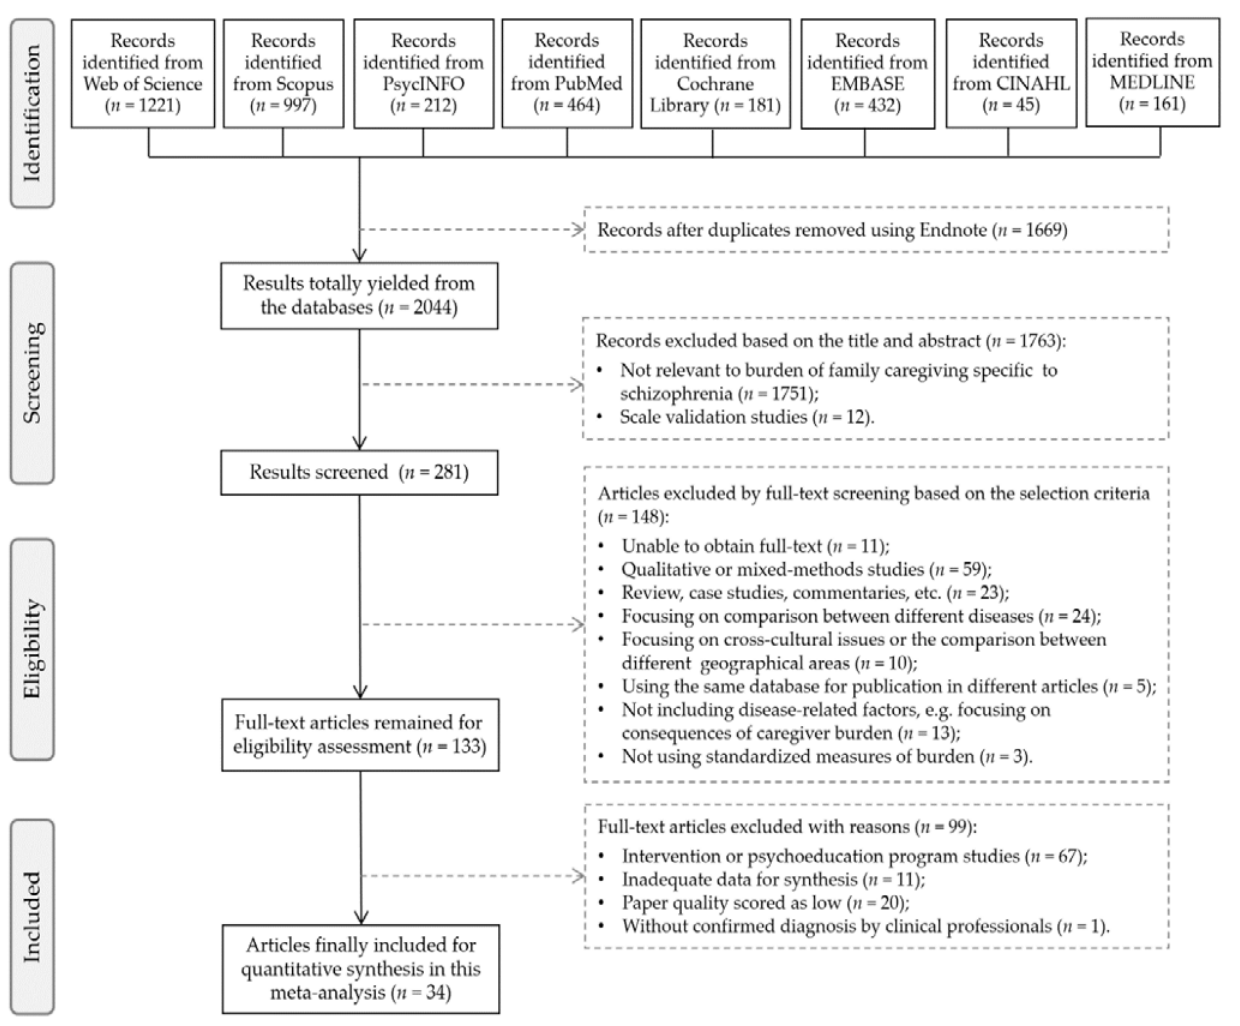
Figure 1. Flowchart of the selection and inclusion procedure.